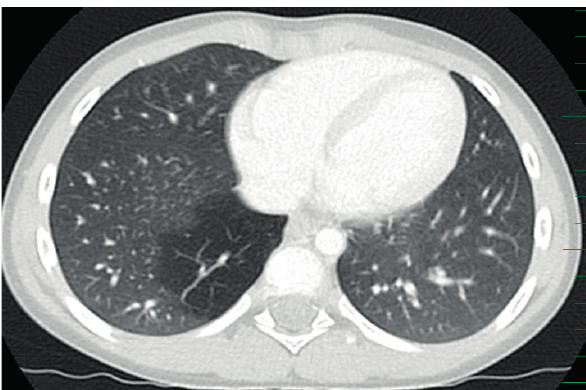
Fig. 1. Focal area of pulmonary hypoattenuation in the right lower lobe (LLL), congenital lung overinflation (CLO).